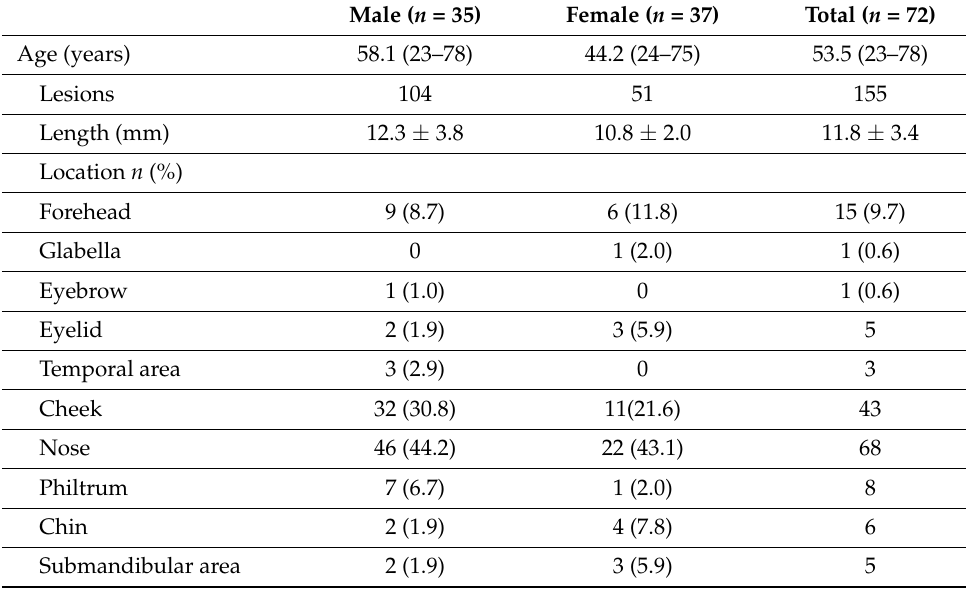
Table 1. Patients’ demographics and characteristics of skin lesions.